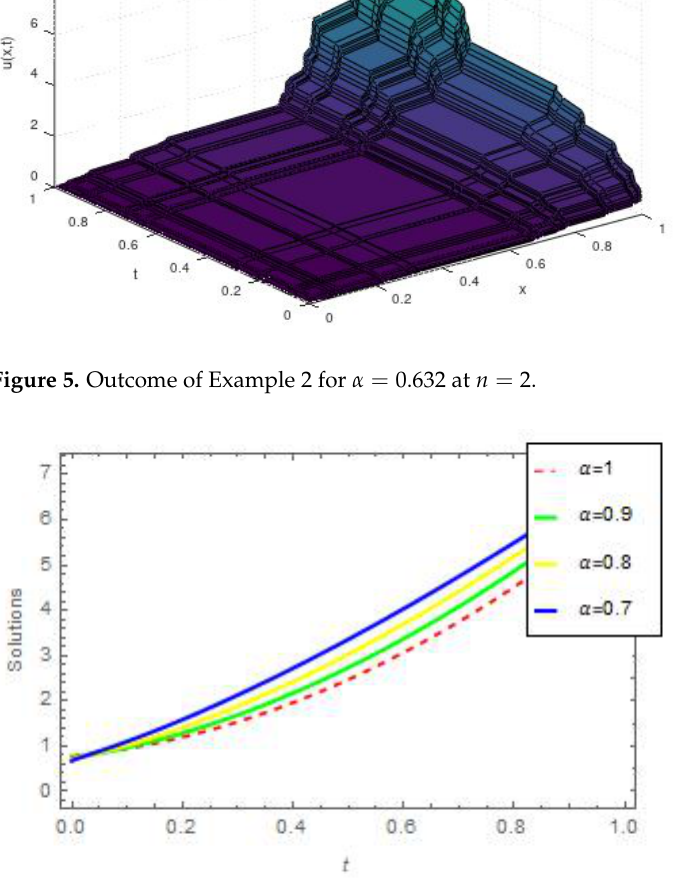
Figure 6. Outcome of Example 1 for different values of α = 1,0.9,0.8,0.7 at n = 2 and x =